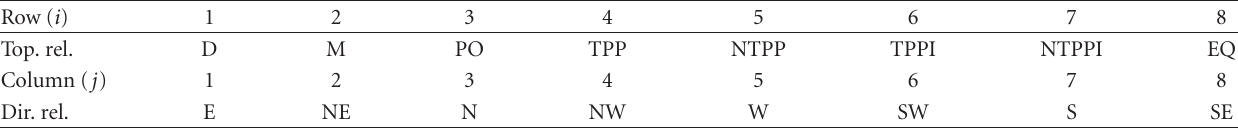
Table 1: Explanation of rows and columns in representation